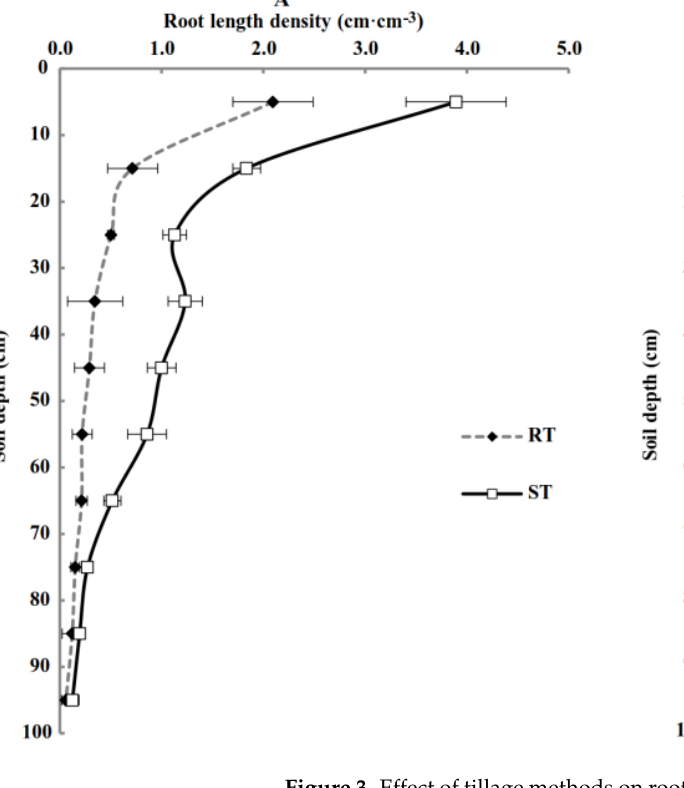
Figure 3. Effect of tillage methods on root length density at 0–100 cm (( A ) booting stage; ( B ) flowering stage). Data are means ± standard deviation ( n = 3).